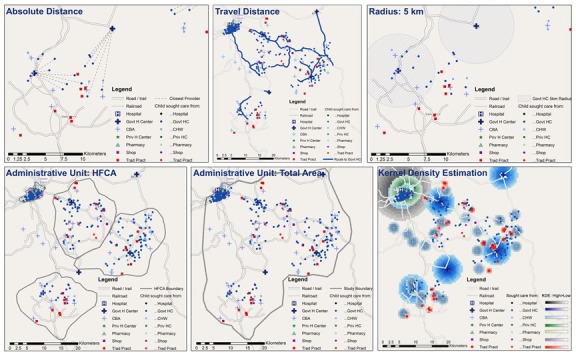
Illustration of ecological linking methods (household locations have been displaced in figure to protect confidentiality).